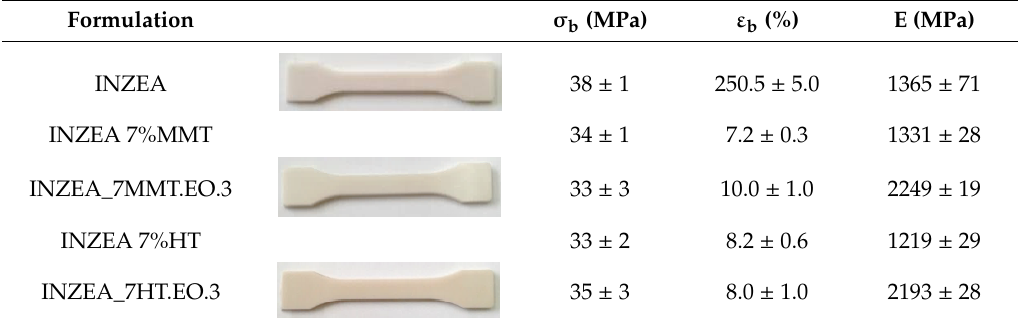
Table 8. Mechanical parameters obtained for INZEA bio-nanocomposites with MMT and HT lemon-hybrid essential oil (EO) (m ± SD; n = 5).